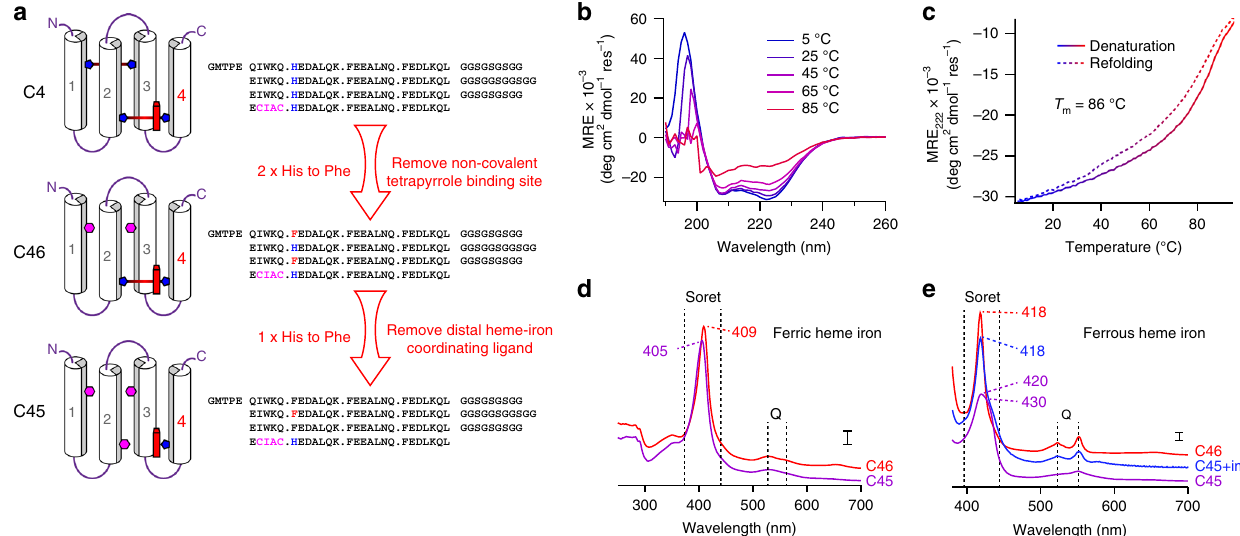
Fig. 1 Design and characterization of an arti fi cial peroxidase. a The design process begins with C4, a CTM containing a bis-histidine heme C-binding site with the consensus motif for covalent heme incorporation on helix 4 with the distal histidine heme ligand on helix 2, and a second non-covalent tetrapyrrole-binding site (occluded by helix 2) consisting of a bis-histidine pair on helices 1 and 3. Mutation of both histidines of the non-covalent-binding site to phenylalanine produces the CTM, C46. Subsequent mutation of the distal heme C-ligating histidine ligand results in the mono-histidine ligated C45. Puri fi cation data are displayed in Supplementary Fig. 1. b Far-UV circular dichroism spectra of C45 with varying temperature collected in 100 mM KCl, 20 mM CHES, pH 8.58. c Temperature dependence of the CD signal monitored at 222 nm during denaturation ( solid line ) and refolding ( dashed line ). d , e UV/visible spectra of ferric ( d ) and ferrous ( e ) C45 ( purple ) and C46 ( red ). The spectrum of ferrous C45 with added exogenous imidazole is displayed in blue . Scale bars represent optical densities of